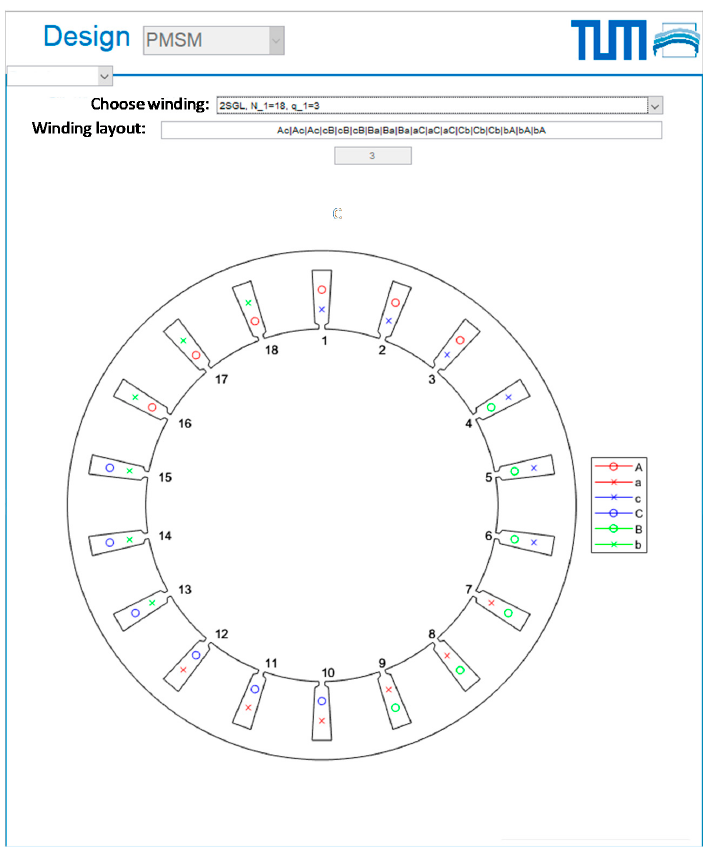
Figure 8. Option Manual—Input or selection of a winding for the design.